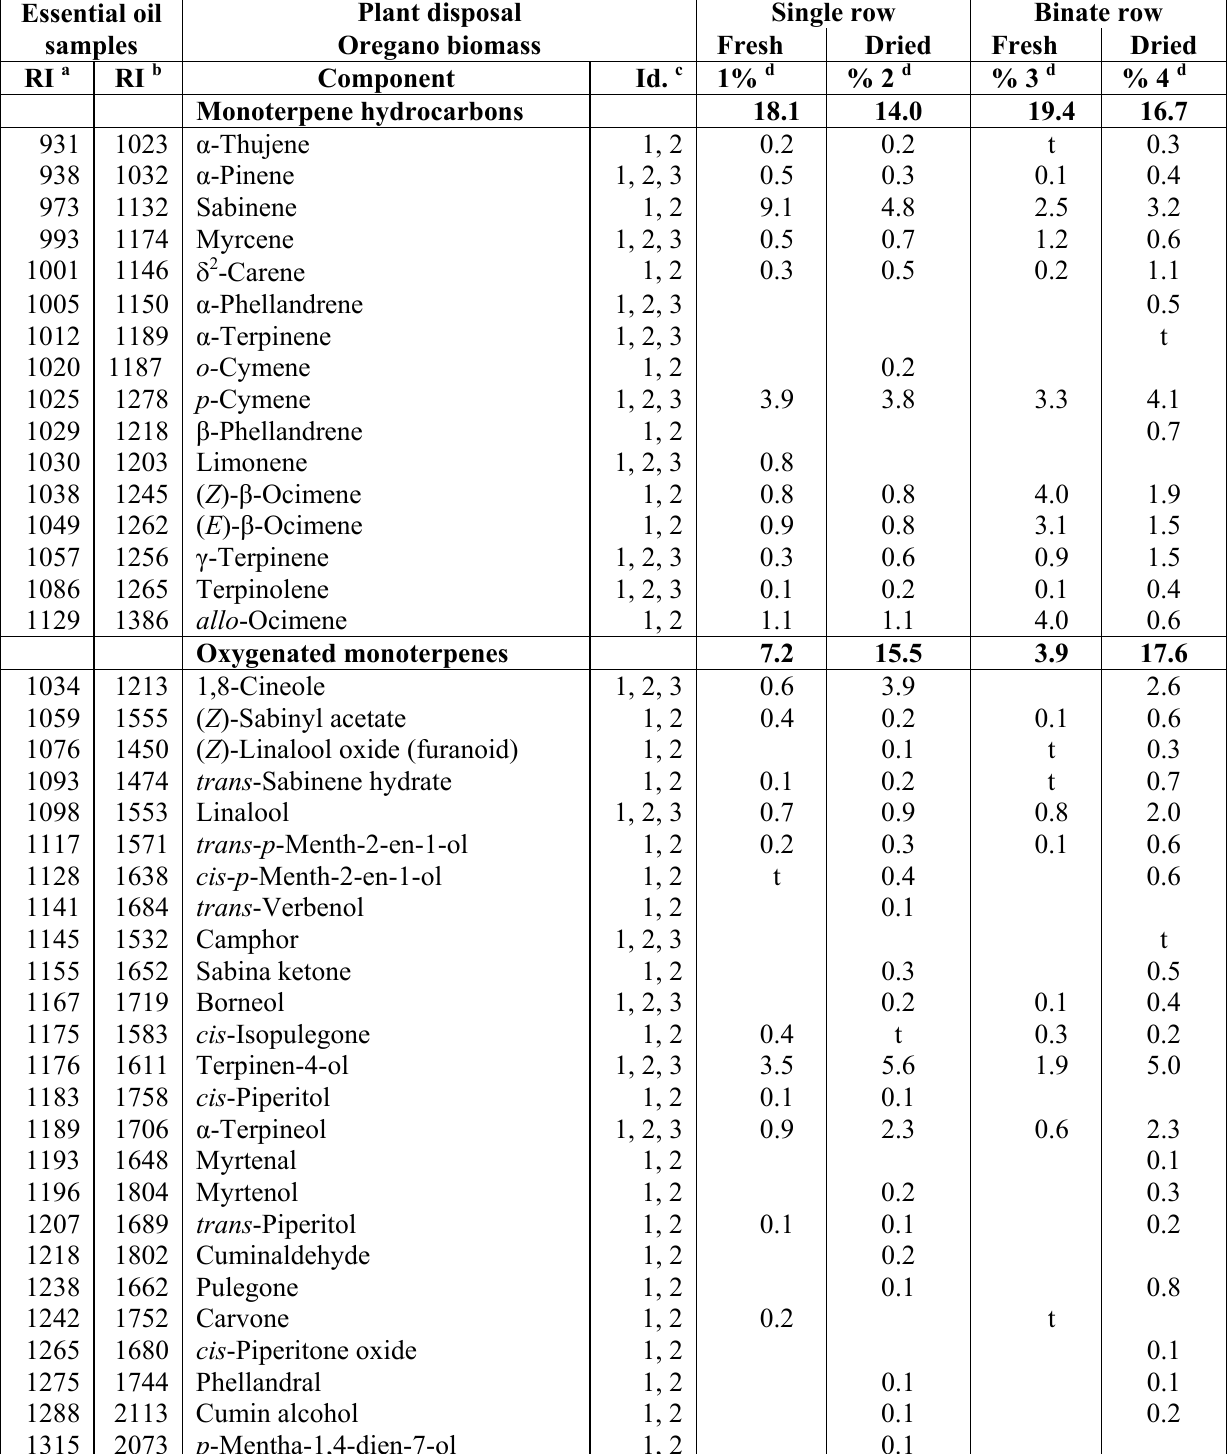
Table 2. Chemical composition of the essential oils from Origanum vulgare L. subsp. vulgare L. samples at full